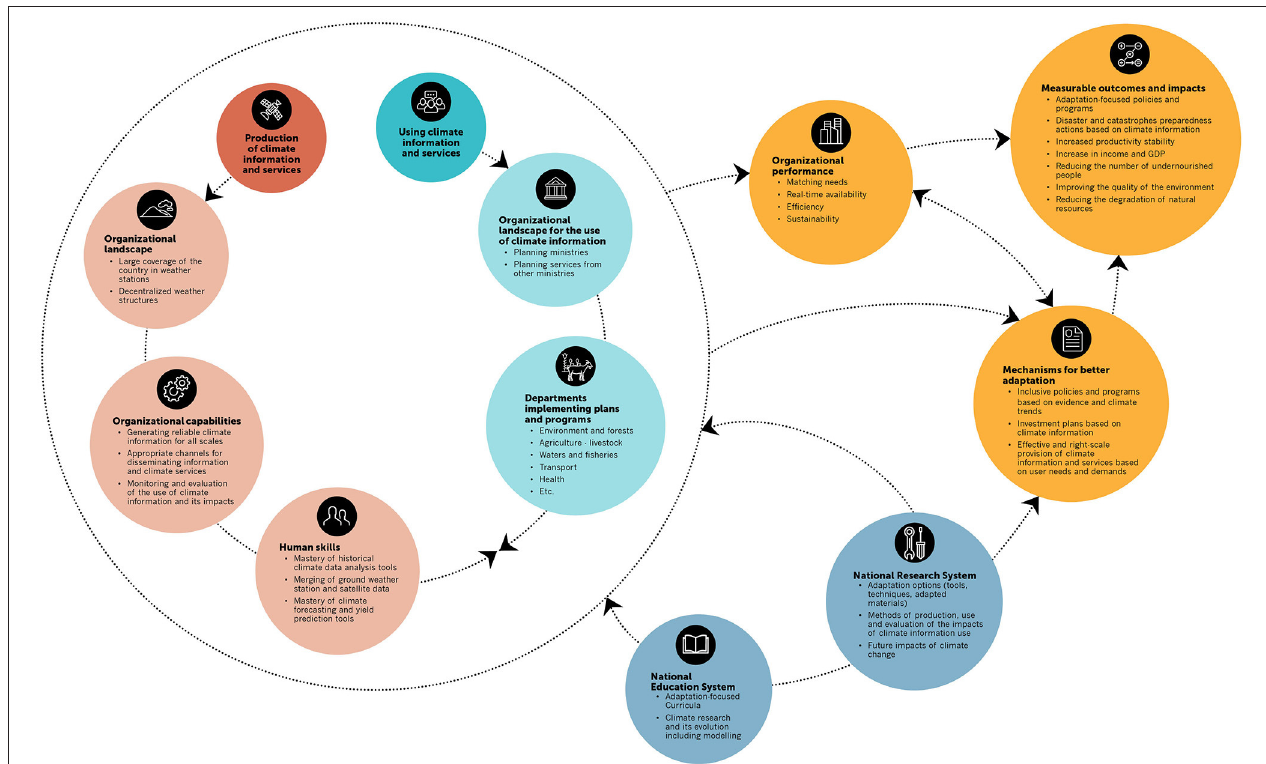
FIGURE 3 | Suggested institutional setup for adapted climate information and advisory services delivery.